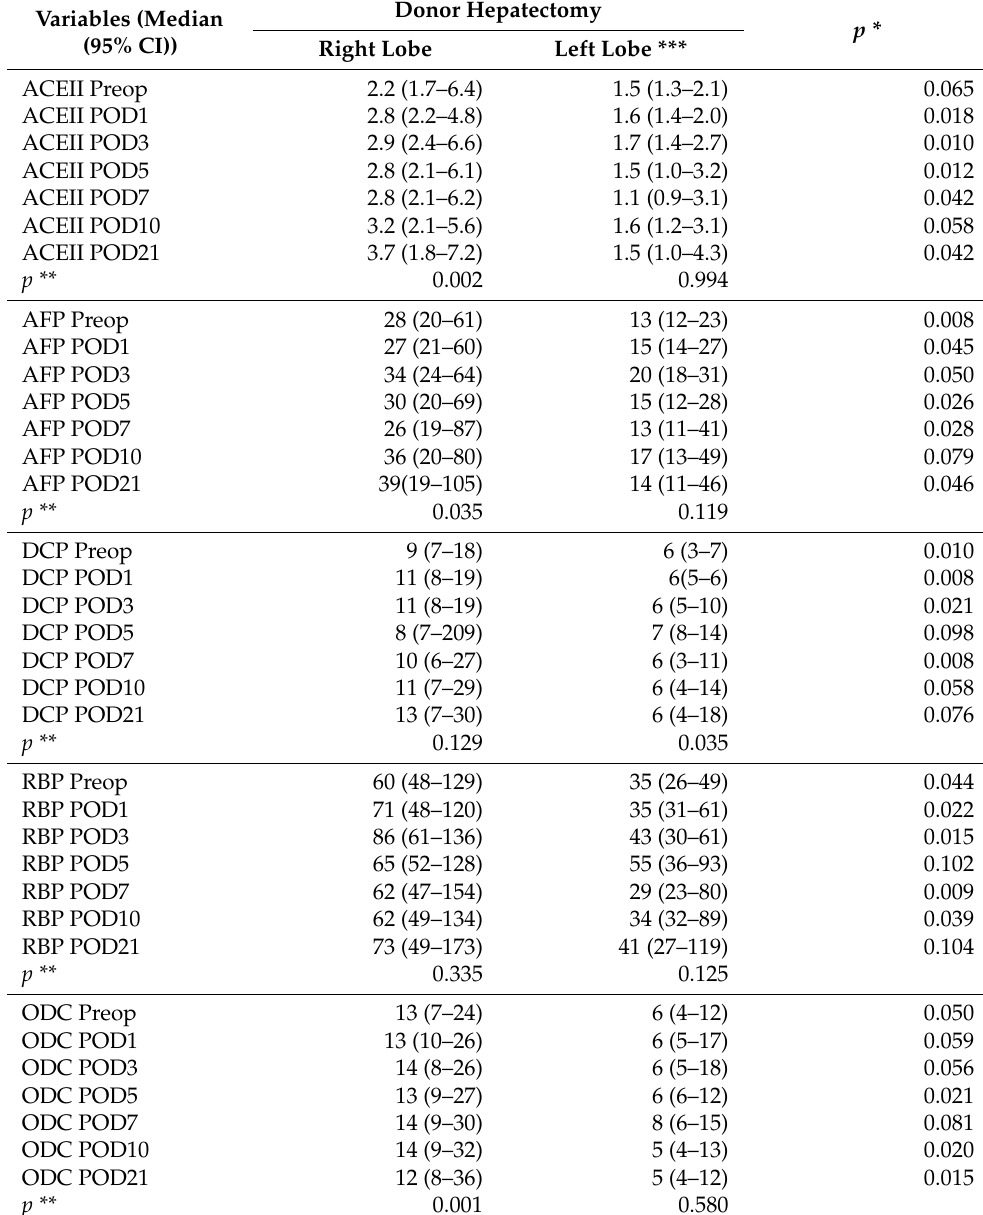
Table 4. Comparison of study subgroups created according to type of hepatectomy (right-lobe LDH vs. left-lobe LDH) type in terms of regeneration-related biochemical